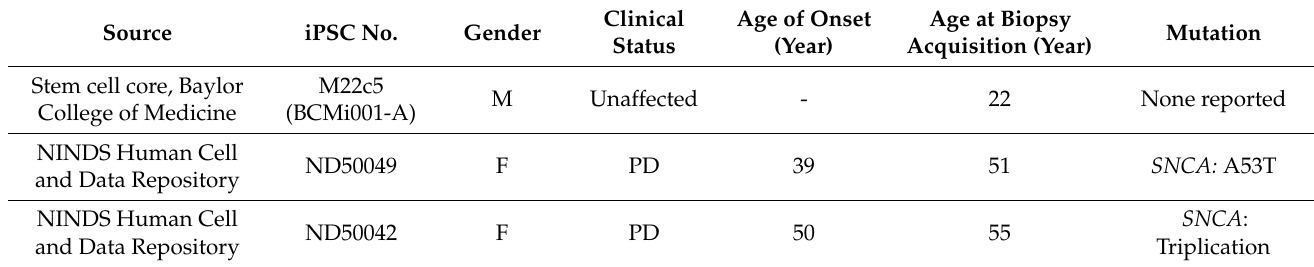
Table 1. Information about patients and healthy control iPSCs